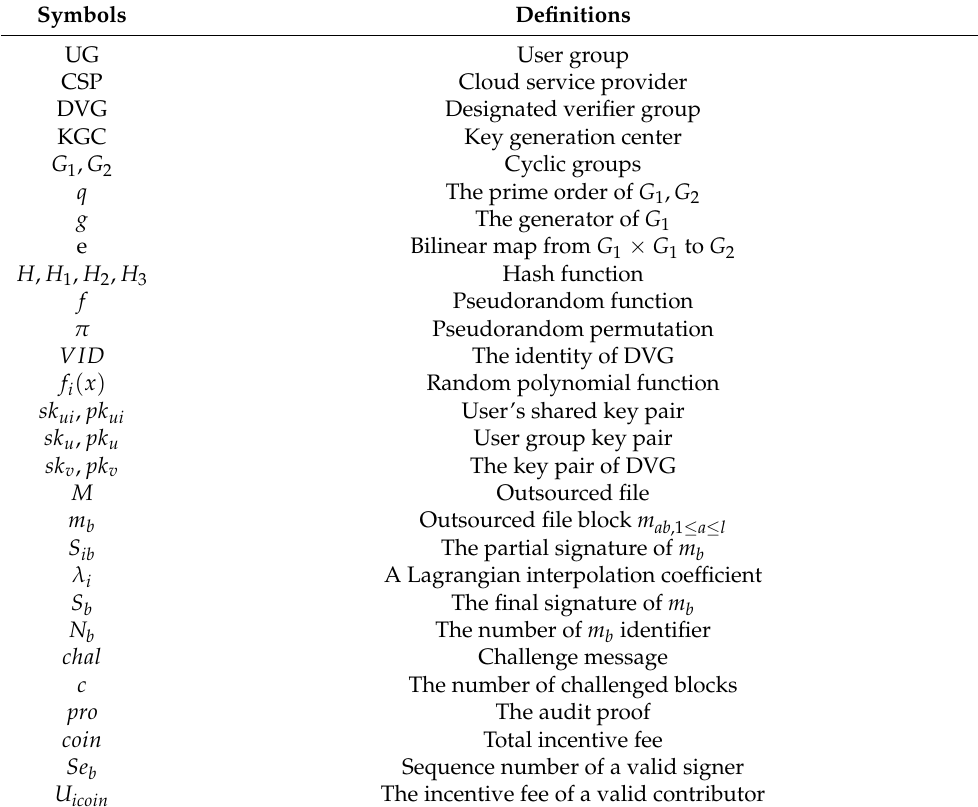
Table 1. Symbols and their